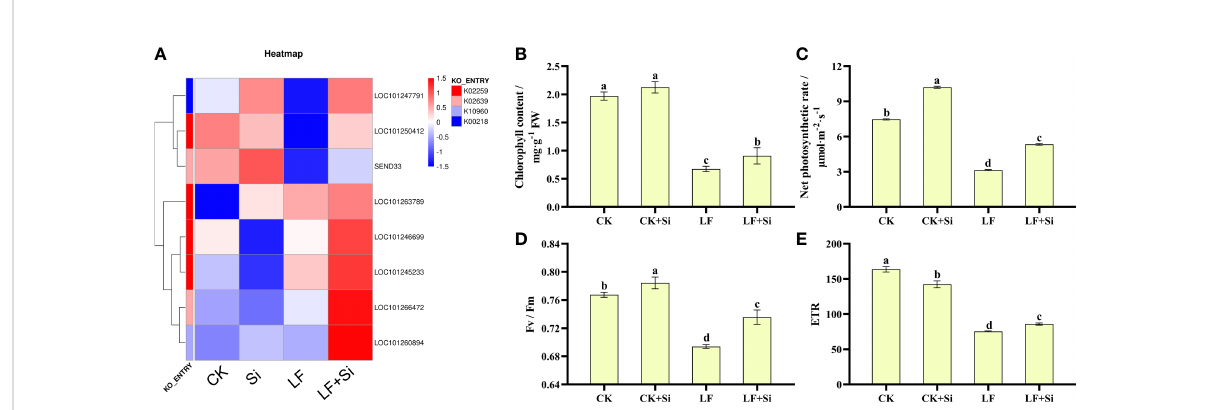
FIGURE 4 Response of photosynthetic capacity of tomato to silicon application under Fe de fi ciency. (A) Heat map of photosynthesis-related differentially expressed genes. (B) Total chlorophyll content. (C) Net photosynthetic rate. (D) Maximum photochemical ef fi ciency of PS II (Fv/Fm). (E) Photosynthetic electron transport rate (ETR). Each data point represents the mean of three independent biological replicates (mean ± SD). Different letters above the bars indicate statistically signi fi cant differences ( P <